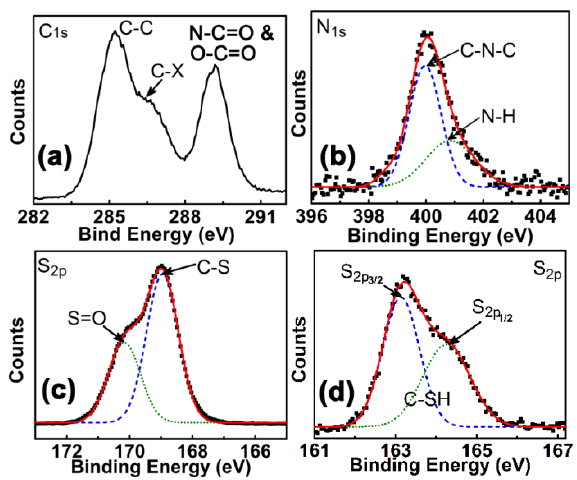
Figure 4. XPS spectra for modified CDs ( a ) a typical C1s; ( b ) N1s; ( c ) S2p of S2 and ( d ) S2p of